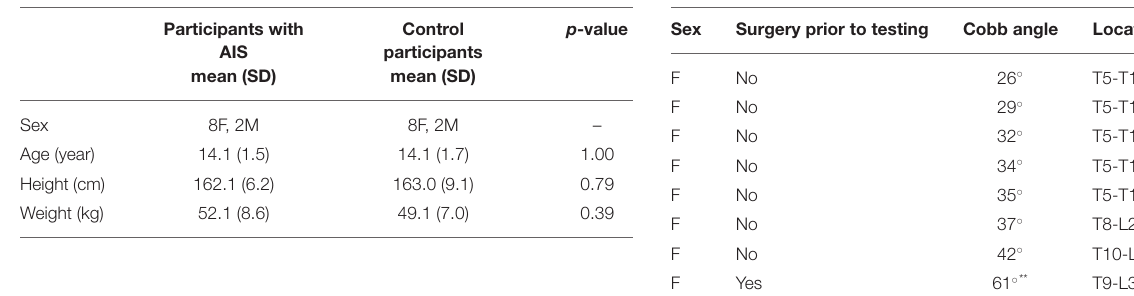
TABLE 1 | Experimental group characteristic comparison. TABLE 2 | AIS participant’s descriptive characteristics of major